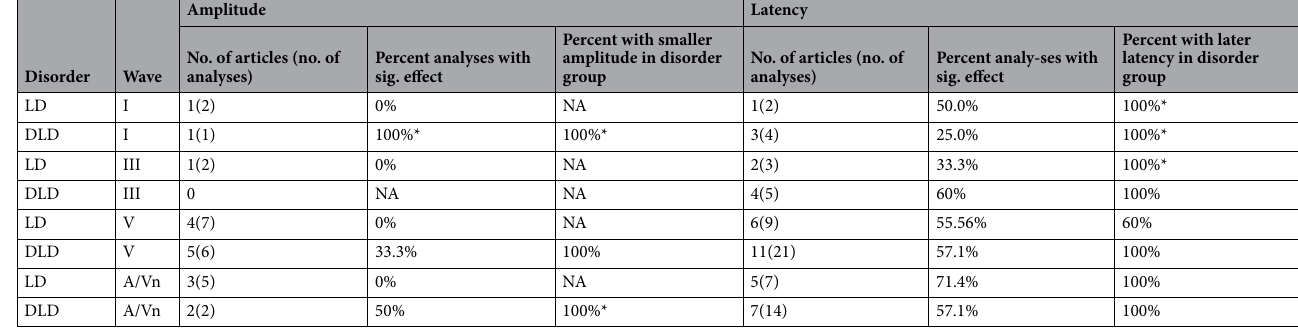
Table 3. Percentages of articles with significant effects in analyses of disorder groups relative to controls and percentages of significant effects that occurred in the same direction. One additional article not included in this table (due to measurement differences in quantifying Wave V) presented significantly lower amplitude in the V-Va complex in children with language-based learning problems relative to controls 32 . Note that one article by Purdy and colleagues 33 included in the LD group Wave V row in this table had participants with both LD and suspected auditory processing disorder. This article found no significant amplitude effect and was the only one with significantly earlier latency for the disorder group relative to controls. Results Significance and Consistency. * Indicates only one analysis included in percentage